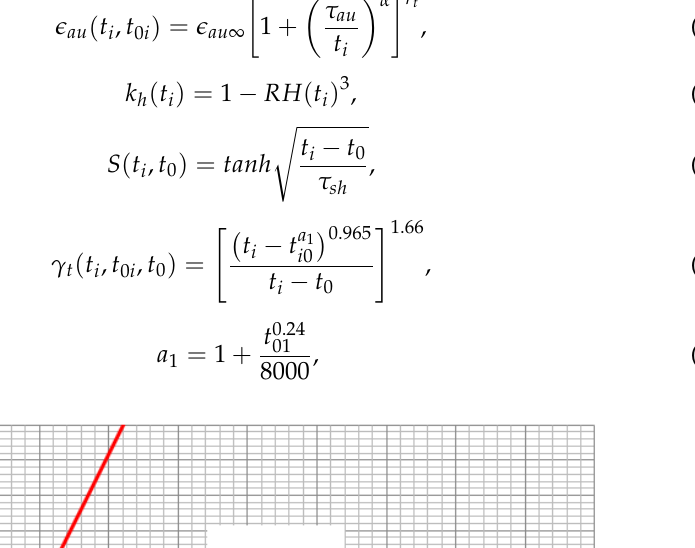
Figure 10. Shrinkage of concrete specimens according to B4 model at the different drying start times when humidity is 70%.